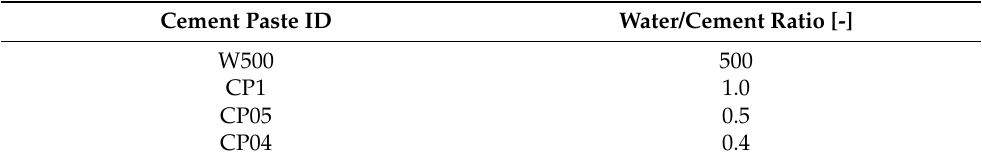
Table 2. Water-to-cement ratios of cement pastes that served as water absorption/desorption envi-